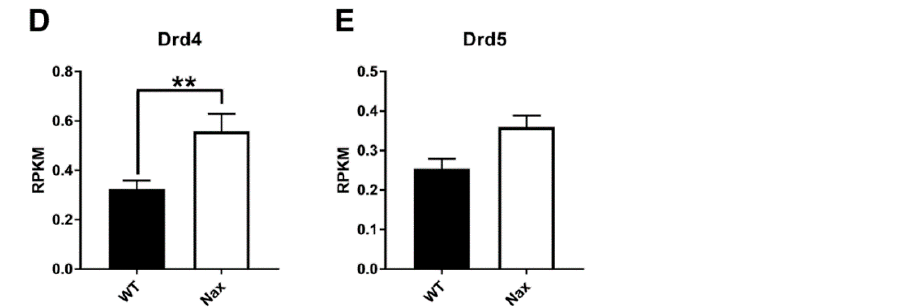
Figure 1. RNA sequencing data analysis in nax ( n = 5) and wild–type (wt) ( n = 6) mice. Data analysis shows dopamine receptor D1 ( Drd1, A ), Drd3 ( C ), and Drd4 ( D ) are significantly increased in the nax cerebellum. Although an increase in Drd2 ( B ) and Drd5 ( E ) is apparent, statistical significance was not reached. The data in the bar graph are presented as the mean ± SEM, and statistical analysis was performed using an unpaired t –test (* p < 0.05 and ** p < 0.01). RPKM: Reads Per Kilobase of transcript per Million mapped reads.